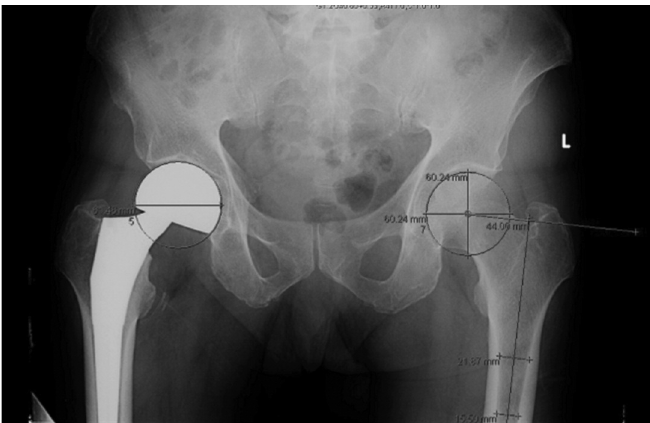
Measurement of medial femoral offset. Step 1: Calculate magnification error (measured shell diameter / actual shell diameter). Fig. 2: Step 2: Identify hip centre. Step 3: Measure femoral head diameter. Step 4: Obtain anatomical axis of femoral diaphysis. Step 5: Using angular measurement tool to obtain perpendicular distance from femoral head centre and deriving the medial femoral offset.